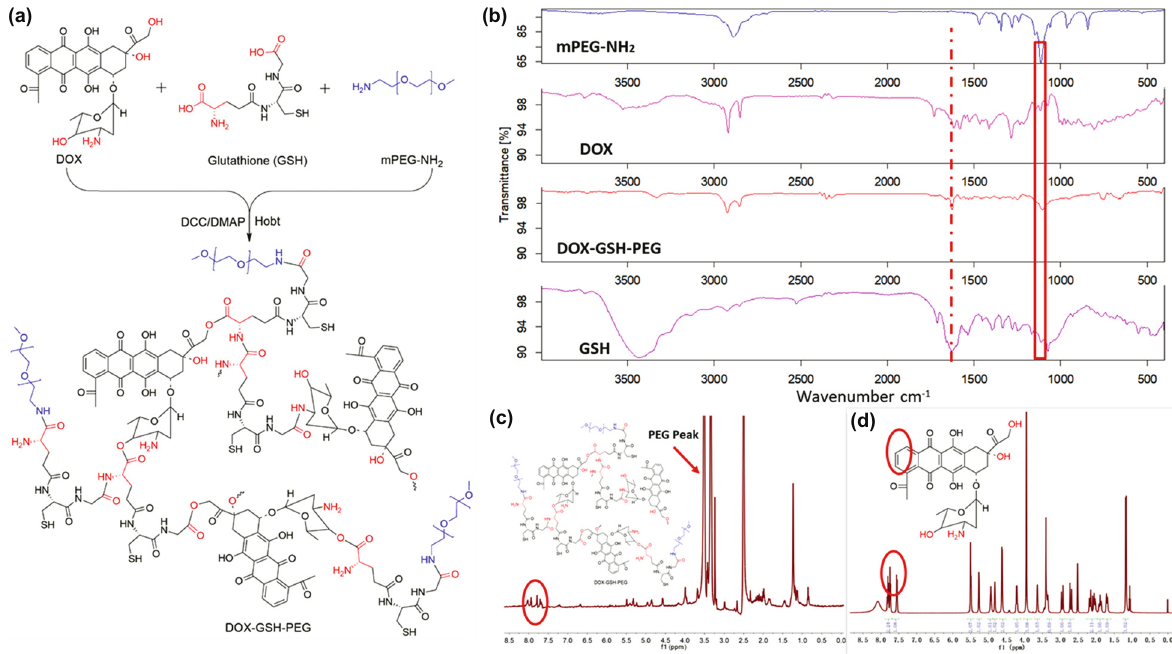
Figure 1: ( a ) Synthesis route of hyperbranched polyprodrug; ( b ) FT - IR spectra of DOX, GSH, PEG, and DOX - GSH - PEG; NMR spectra of ( c ) DOX - GSH - PEG and ( d ) free DOX in DMSO - d 6